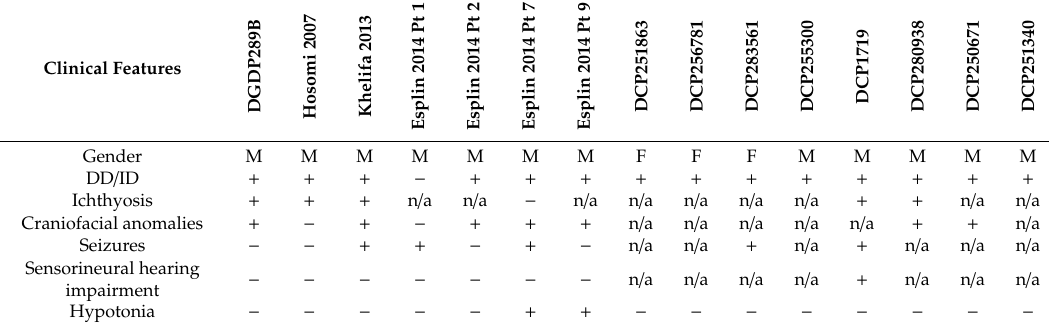
Table 5. Clinical features of patients with Xp22.31 microdeletions and